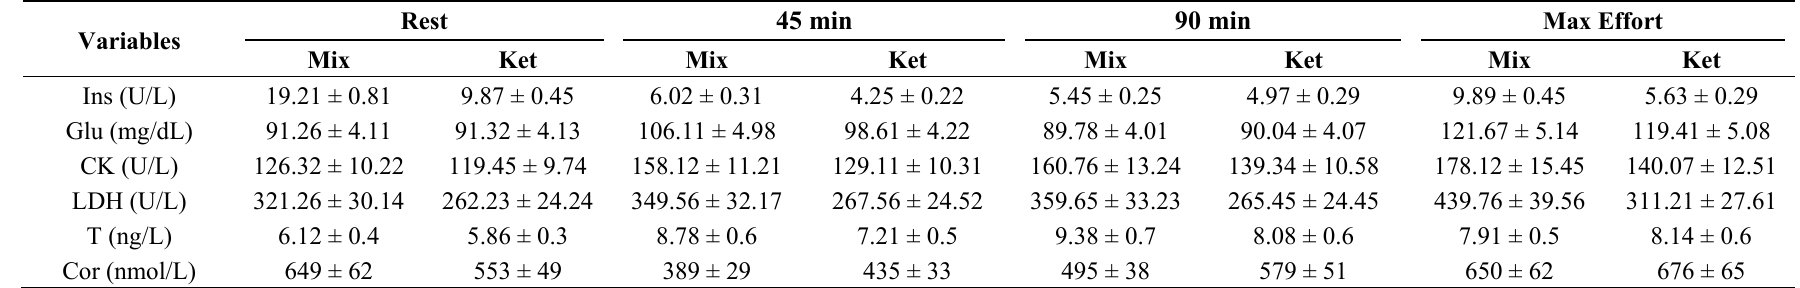
max, VO LT and LT work load) in off-road cyclists after a mixed (Mix) and ketogenic 2 2